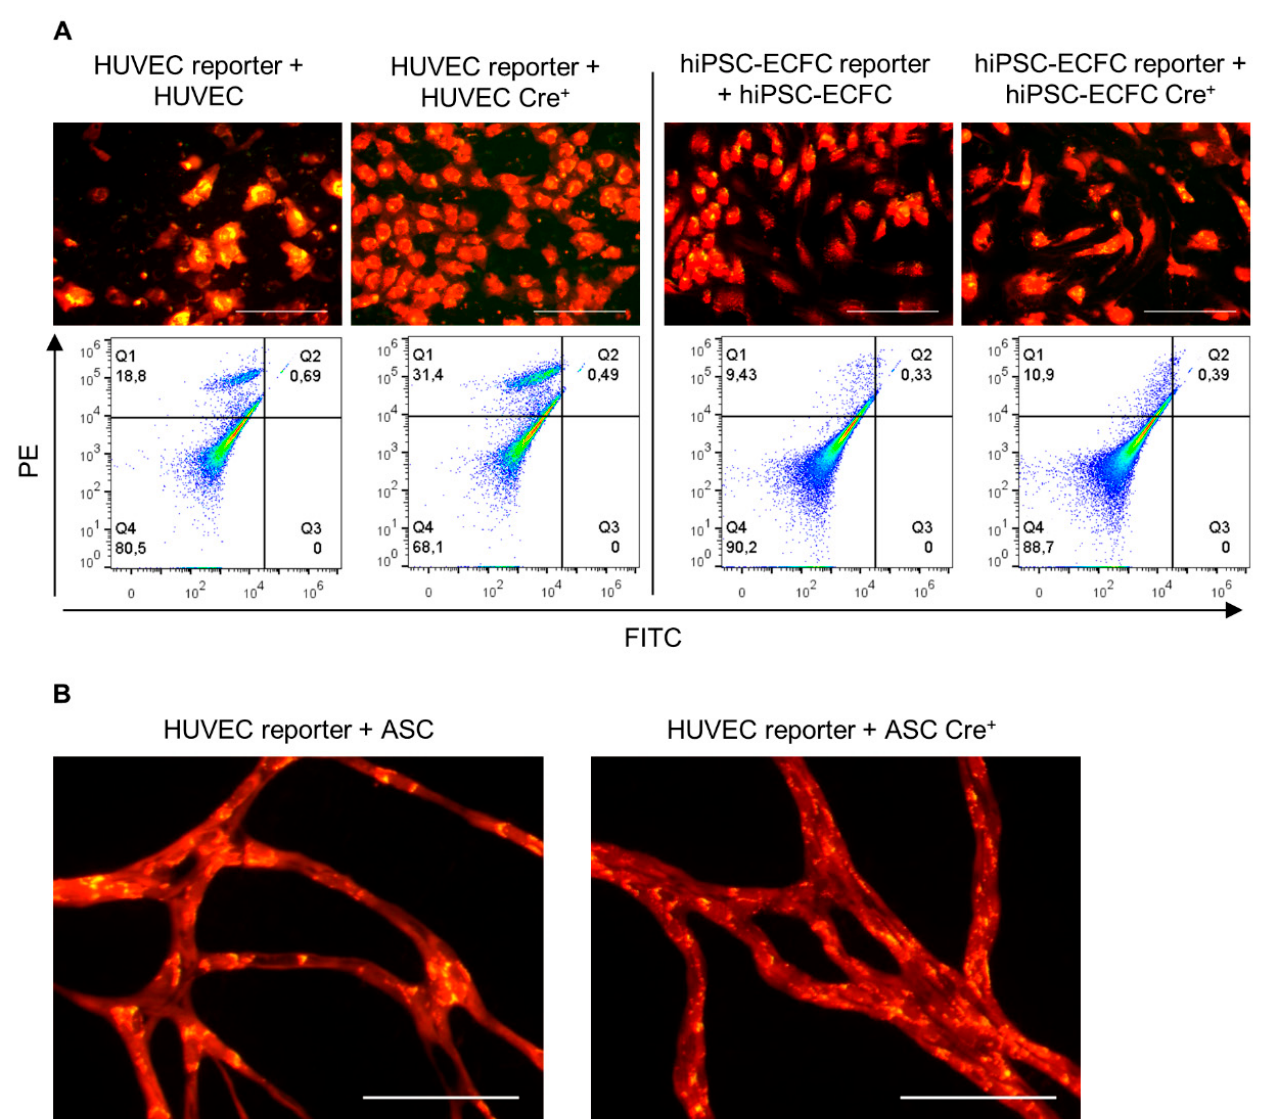
Figure 4. Coculture of Cre + and reporter cells. HUVEC and hiPSC-ECFC reporter cells were either cocultured with Cre + cells of the same cell type or ASC. ( A ) Cocultures of HUVEC and hiPSC-ECFC with Cre + cells or uninfected HUVEC and hiPSC-ECFC (1:10 reporter cells: Cre + cells). Quadrant regions show the percentage of cells in each subpopulation either expressing dsRed (PE, Q1), eGFP (FITC, Q3), both (Q2), or non-fluorescent (Q4). ( B ) HUVEC reporter cells were either cocultured with Cre + or uninfected ASCs (1:50 reporter cells: Cre + cells). Data was obtained from three independent experiments using two different cell donors for HUVEC and ASC and one cell donor for hiPSC-ECFC. n = 2 cell donors. Scale bar: 100 µm.